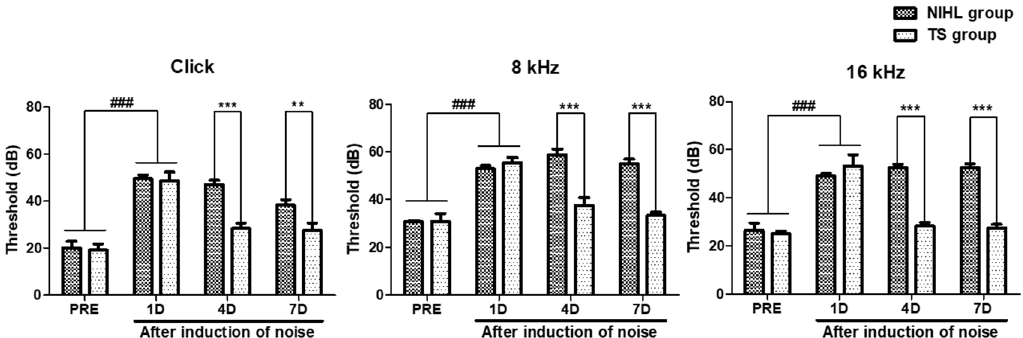
Figure 4. Comparison of hearing thresholds in noise-induced hearing loss mice with and without TS treatment. Hearing thresholds of noise-induced hearing loss (NIHL) and TS groups (TS) were measured using clicks and 8 and 16 kHz tone bursts prior to (PRE) and 1, 4, and 7 days (1D, 4D, and 7D) after noise exposure. Data are presented as means ± SEM. Data were analyzed using two-way ANOVA followed by Bonferroni post hoc test. ### p < 0.001 (PRE vs. 1D). ** p < 0.01 and *** p < 0.001 (NIHL vs. TS). N = 10 per group.